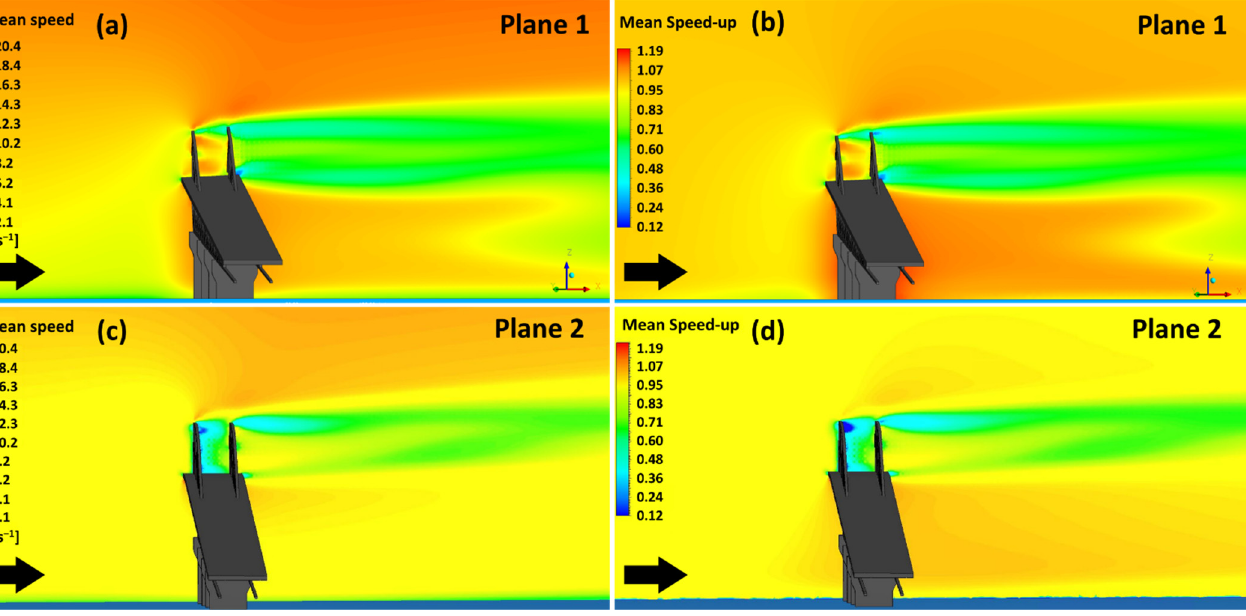
Figure 9. Wind speed results on two cross-sectional planes along the width of the bridge: ( a ) mean speed on Plane 1; ( b ) mean speed-up on Plane 1; ( c ) mean speed on Plane 2; ( d ) mean speed-up on Plane 2.